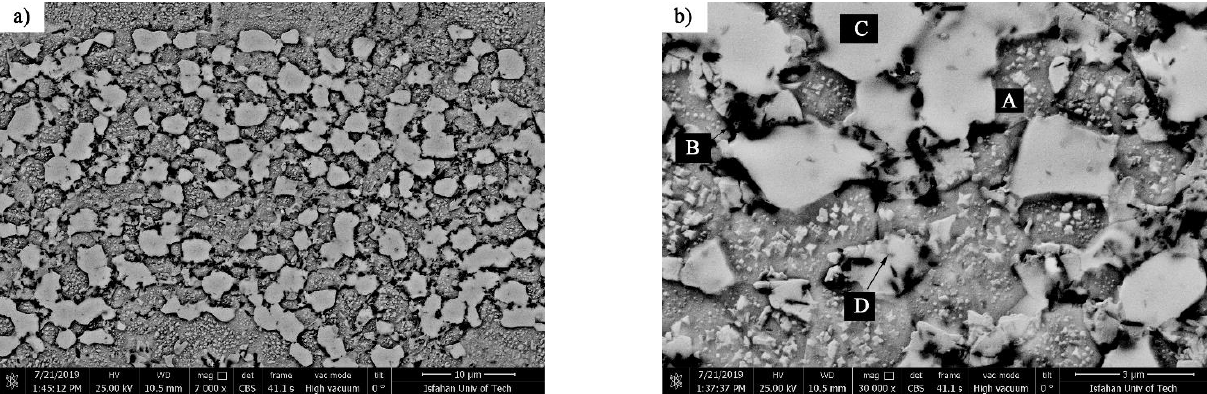
Figure 6. The scanning electron microscopy (SEM) microstructure of the interlayer annealed at 980 °C for 10 min: ( a ) low and ( b ) high magnification. Note: (A) α -Ni, (b) α′ -Ni, (C) Ni 3 B and (D) Ni-Si-B compounds.